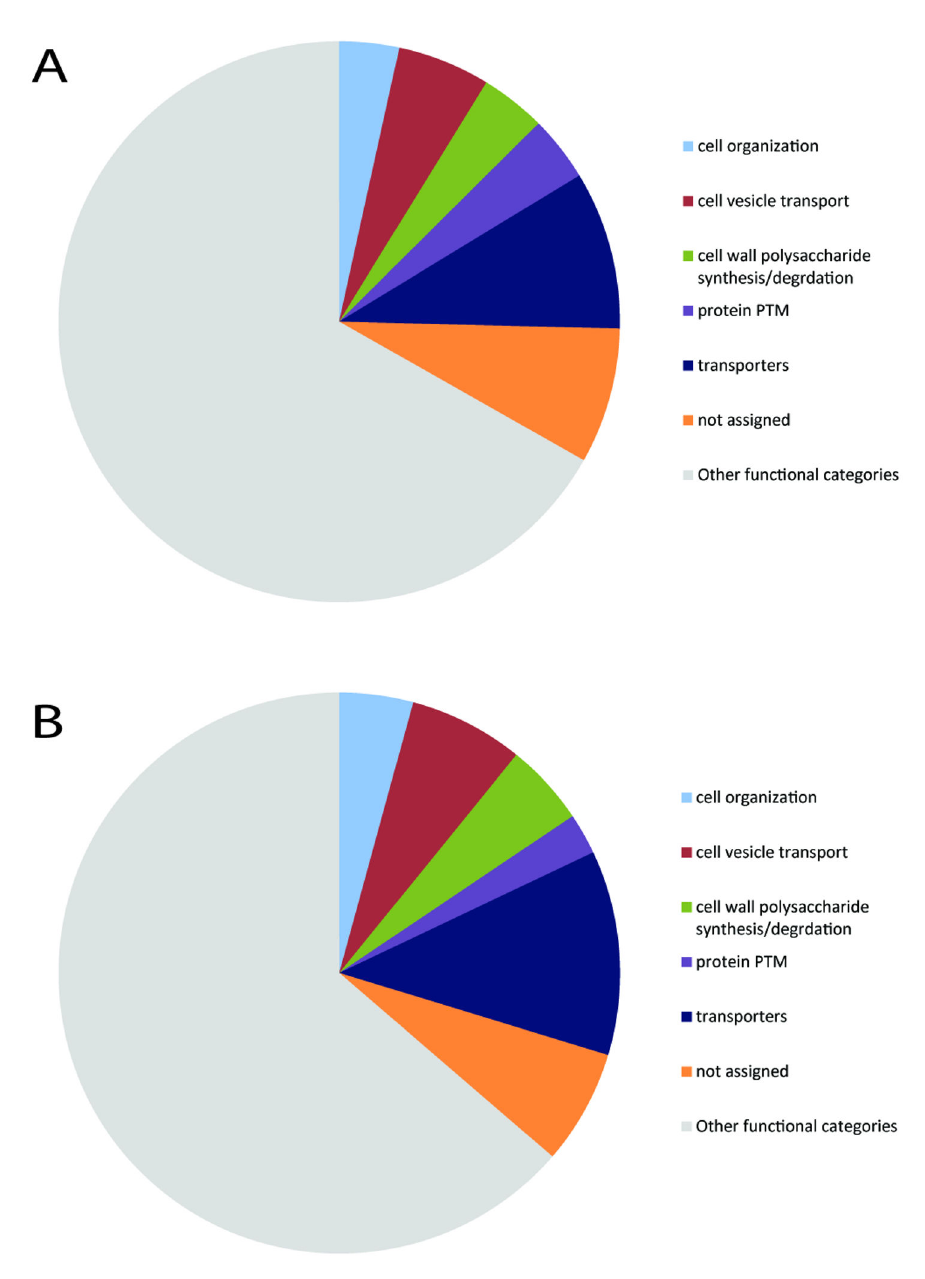
Figure 2. Differences in MapMan functional categories for proteins identified from mCW and sCW samples. Proteins identified from mCW ( A ) and sCW ( B ) samples using the Arabidopsis database were allocated into MapMan bins [25]. Only functional categories with differences are shown. Functional classes with little discernable difference were allocated to ‘other functional